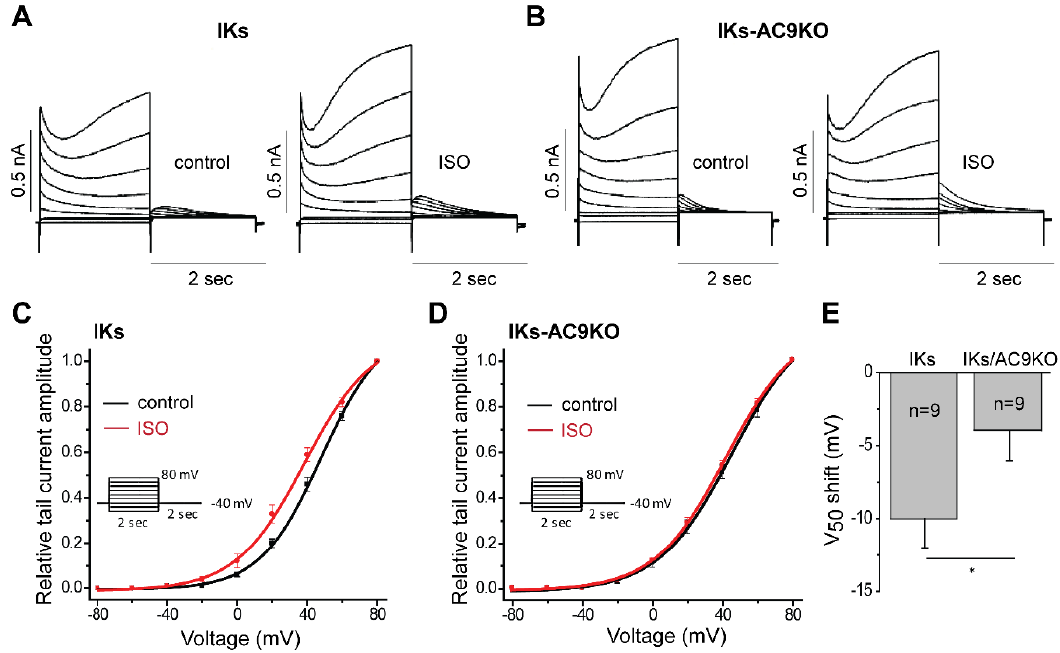
Figure 4. AC9 deletion impairs isoproterenol-induced regulation of I Ks . I Ks currents in ventricular myocytes of IKs ( A ) and IKs-AC9KO ( B ) mice in before (control, left panels) and after perfusion of 1 µM isoproterenol and 1 µM okadaic acid (ISO, right panels). Currents were elicited by applying depolarizing potentials to various levels ranging from −80 to +80 mV for 2 s from a holding potential of − 40 mV. I-V relationships for tail current in IKs ( C ) and IKs-AC9KO ( D ) before (control) and after